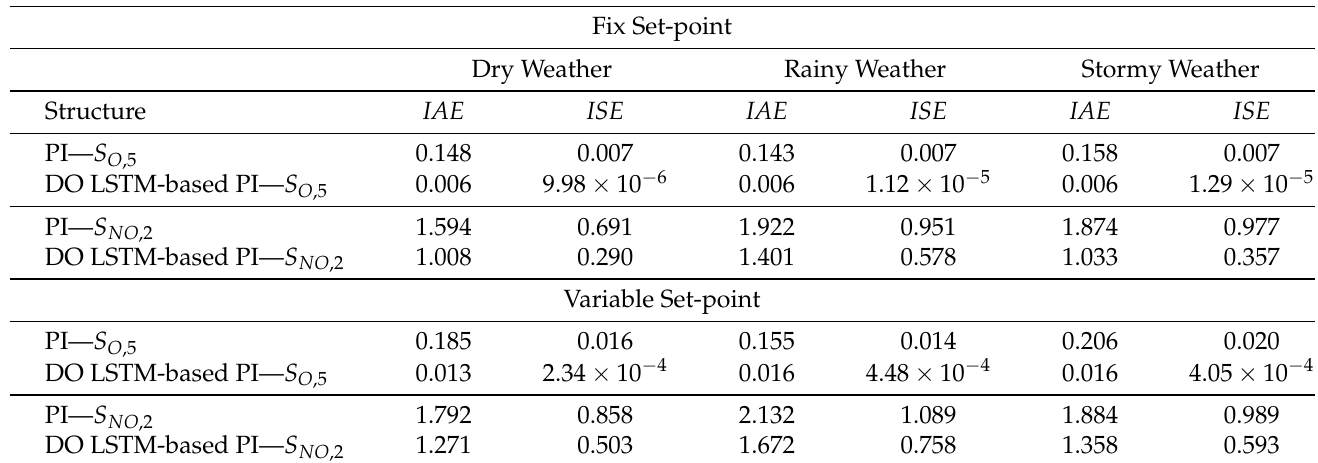
Table 2. Control performance when the DO LSTM-based PI derived from the DO control loop is transferred into the NO control loop. Transfer Learning from DO to NO Control